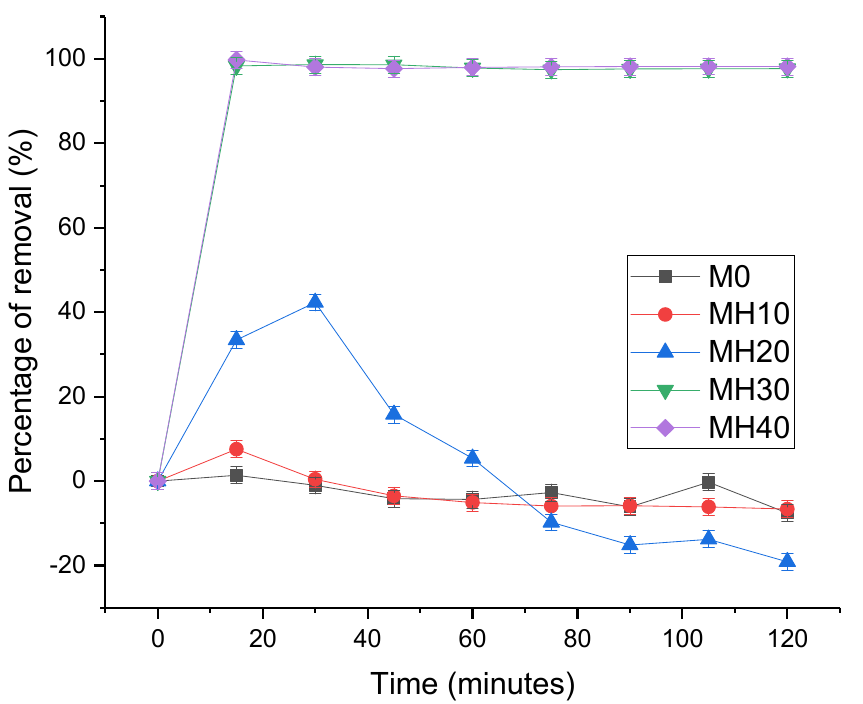
Figure 11. Dynamic adsorption-filtration testing for M0, MH10, MH20, MH30, MH40. The error bars indicated standard deviation at each time point. The experiment was carried out three times to ensure accurate results.